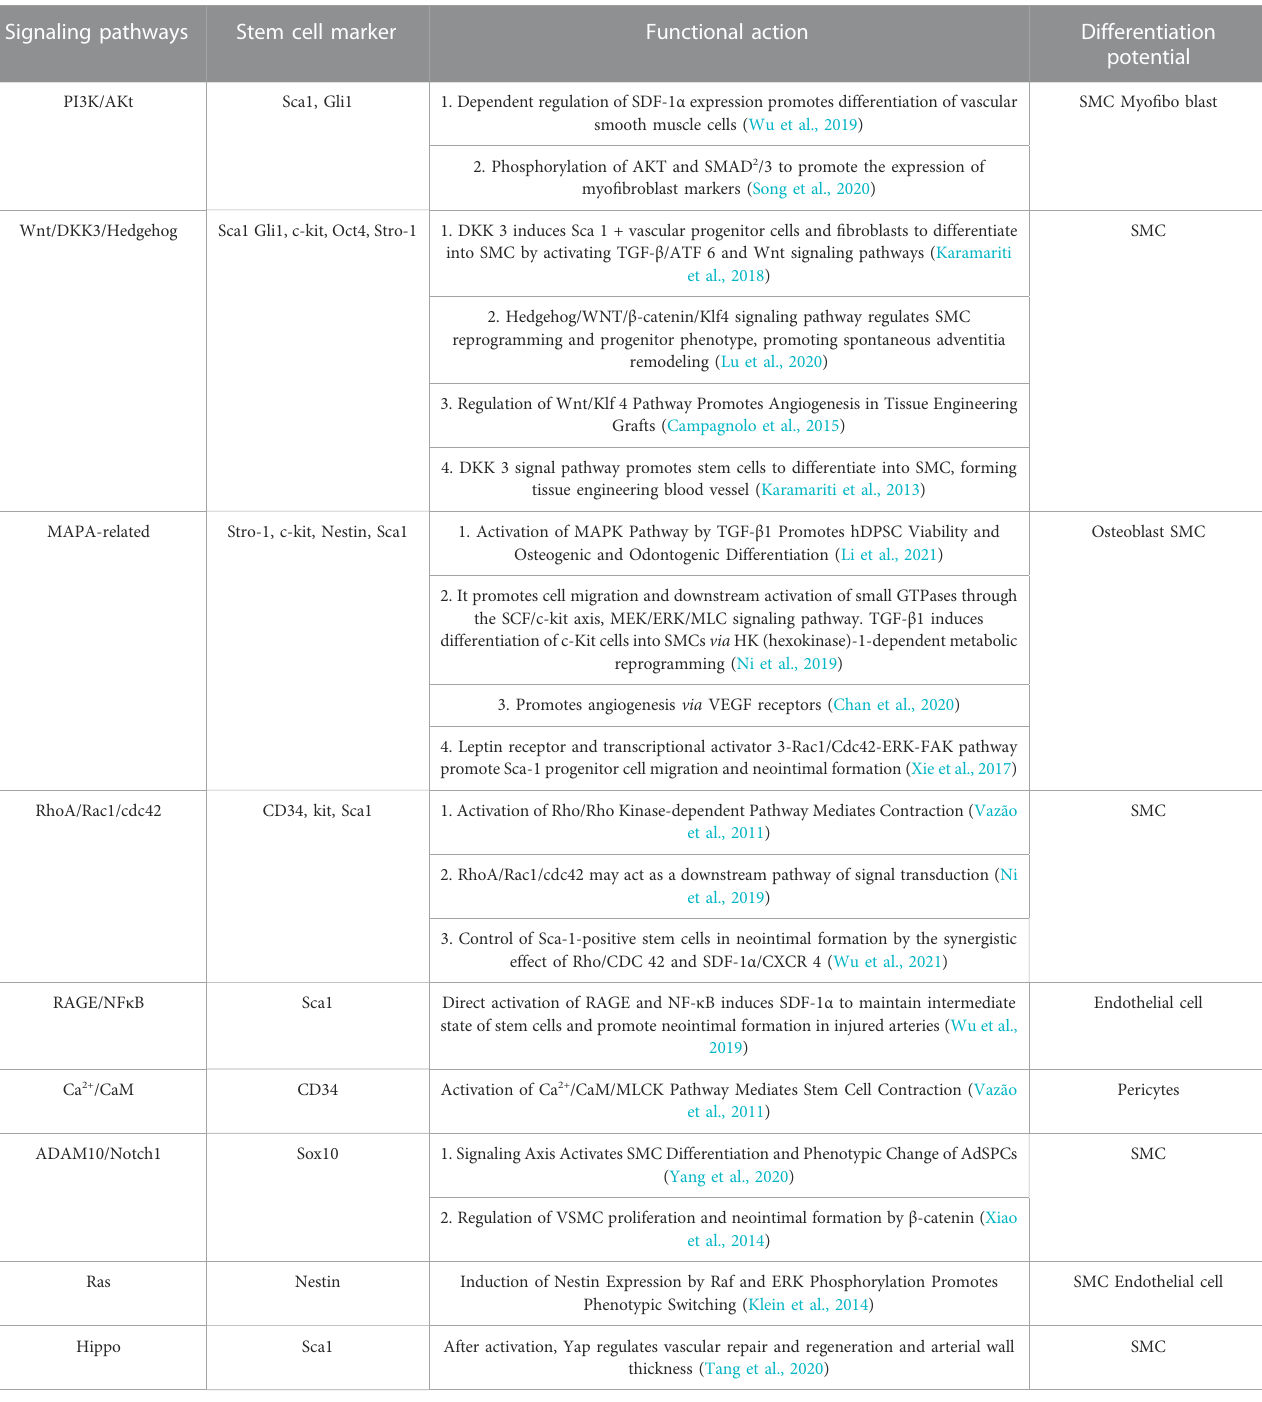
TABLE 2 Signaling pathways in different stem cell populations: similarities and